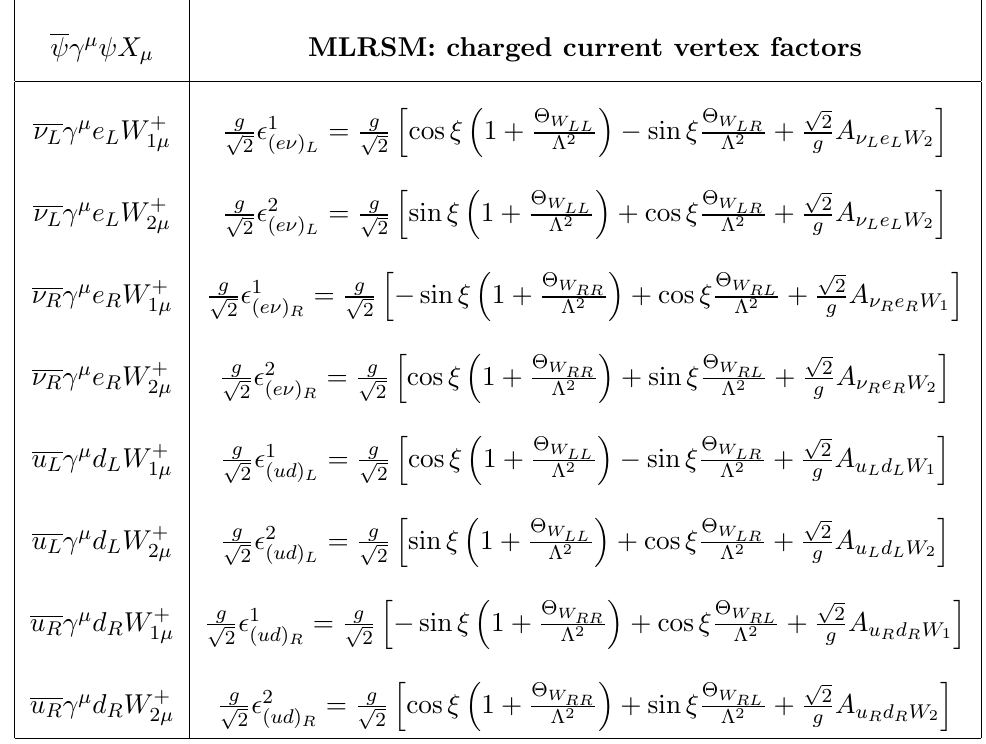
. 2cos (cid:18) w sin (cid:18) w